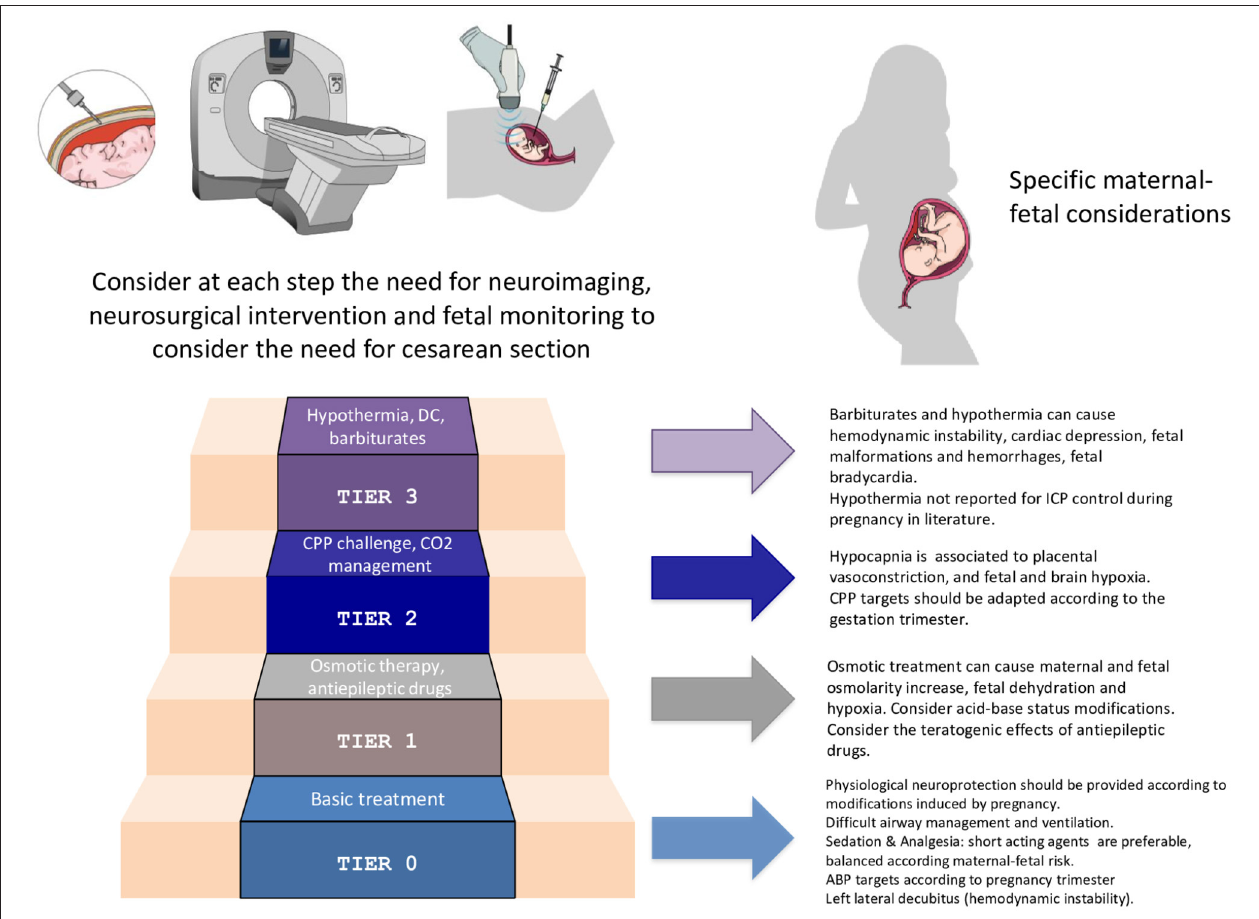
FIGURE 3 | Specific considerations for the application of the staircase approach for intracranial pressure management in the pregnant woman. ICP, intracranial pressure; CPP, cerebral perfusion pressure; DC, decompressive craniotomy; ABP, arterial blood pressure.